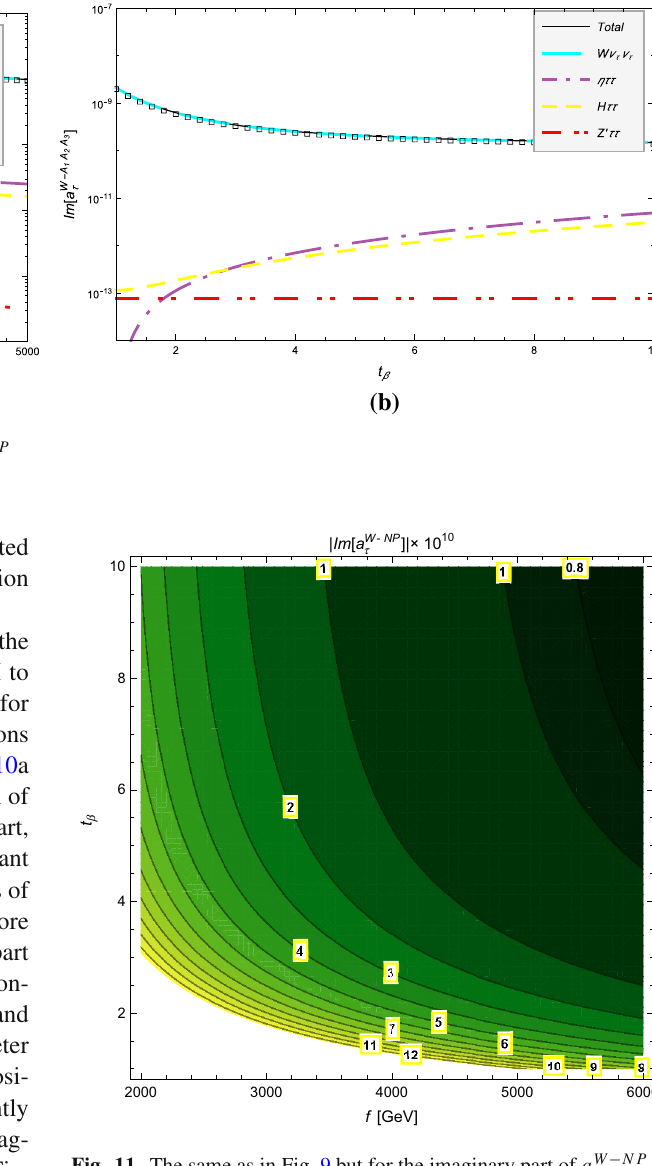
Fig. 11 The same as in Fig. 9 but for the imaginary part of a W − NP